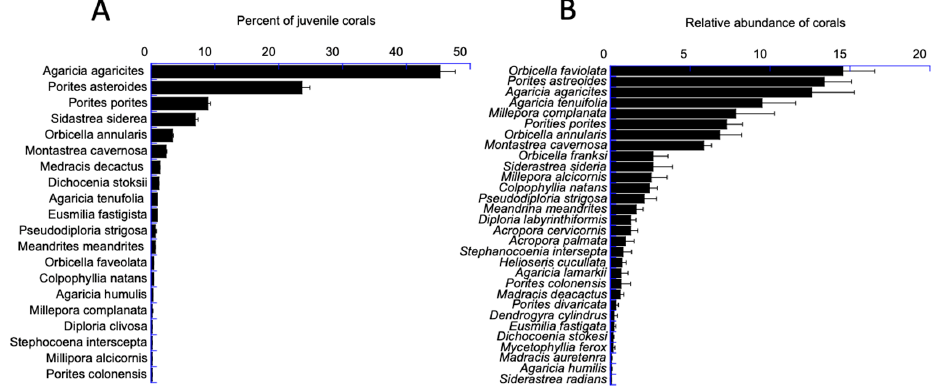
Figure 13. Relative abundances for juvenile ( A ) and adult ( B ) coral species. Juvenile (N, 20 spp.) and adult (N, 30 spp.) coral averages are for all sites and all years.